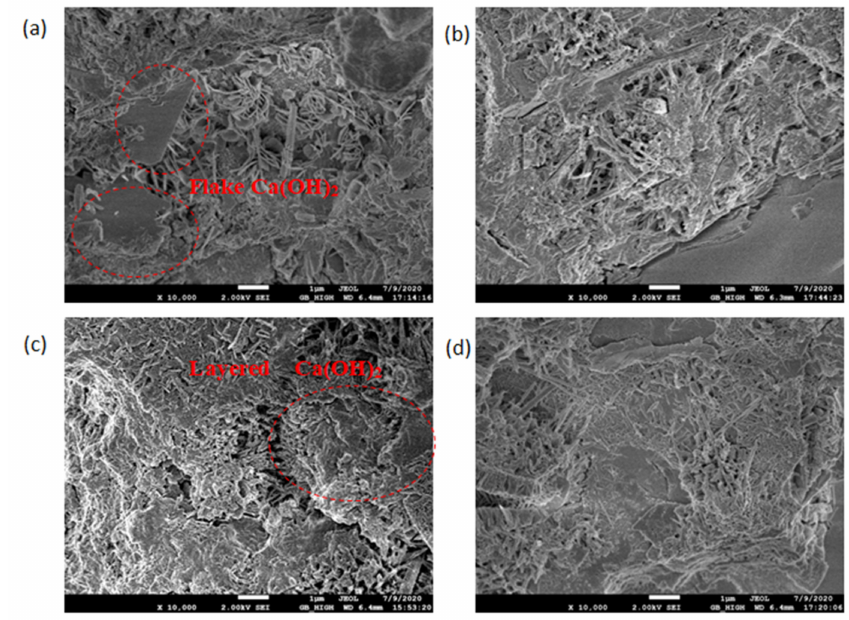
Figure 10. SEM diagram of pure cement paste (FA replacement ratio is 0%) at 7 days of age: ( a ) pH = 7.6 OW; ( b ) pH = 9.5 AEW; ( c ) pH = 10.5 AEW; ( d ) pH = 11.5